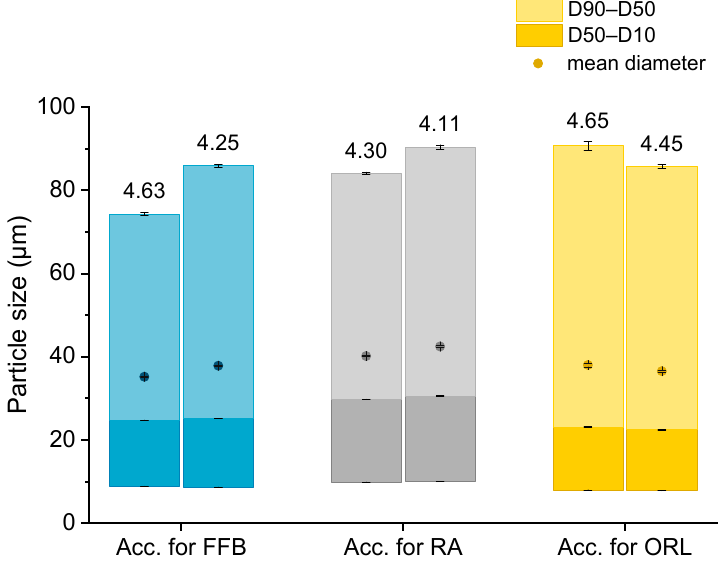
Figure 1. Particle size (represented as bars, all values n = 3 measurements ± SD) and lipid concen- tration (%) as determined by DSC (respective values above bars) of the different lipid-containing hydrogel bead dispersions utilized as acceptors (Acc.) in the respective transfer experiments. Fur- ther abbreviations: FFB—fenofibrate, RA—retinyl acetate, ORL—orlistat.